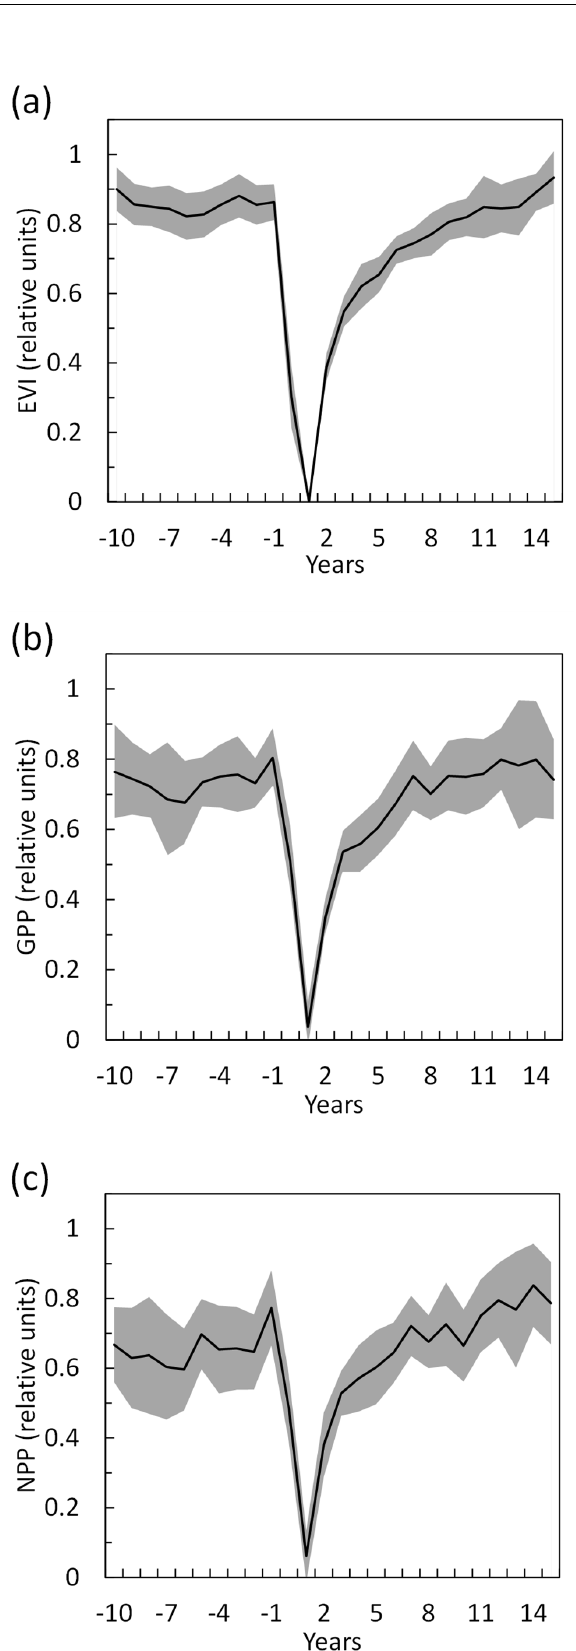
Figure 4. Vegetative recovery of burnt areas in the Siberian Arctic. The year of the fire is set at 0. ( a ) Enhanced vegetation index. ( b ) Gross primary productivity. ( c ) Net primary productivity. Shaded areas represent the 95% confidence interval around the trend line.